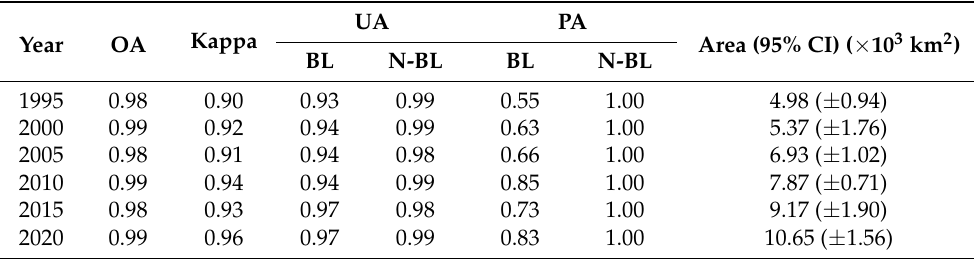
Table 4. Accuracies assessment, area estimation and its 95% confidence interval in Guangdong in